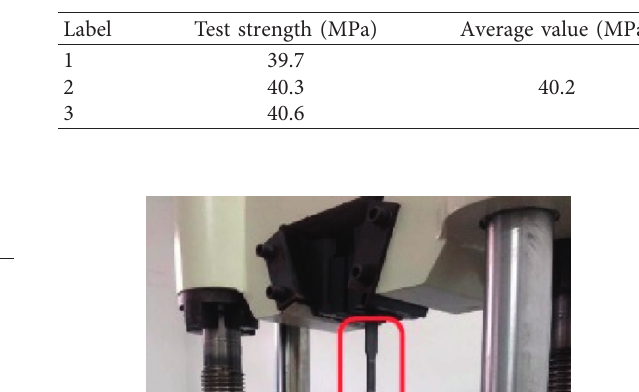
Table 3: Experimenting strength of concrete.